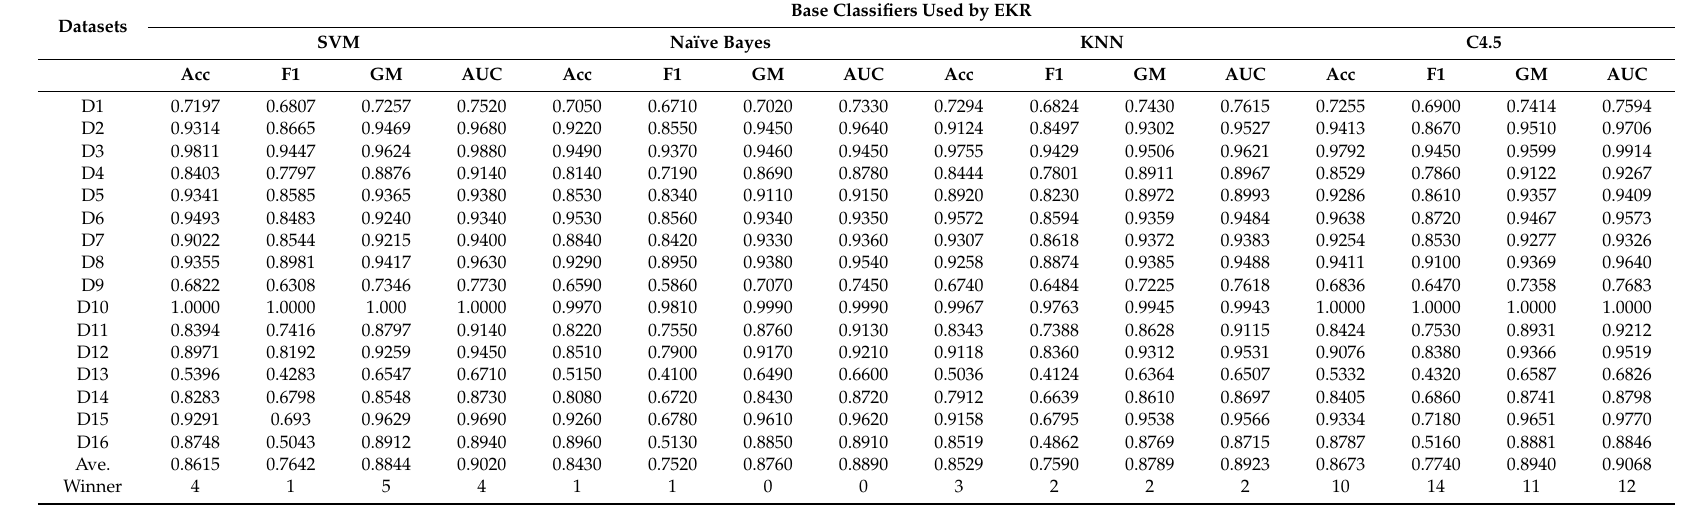
Table 3. Classification performance of EKR with di ff erent base